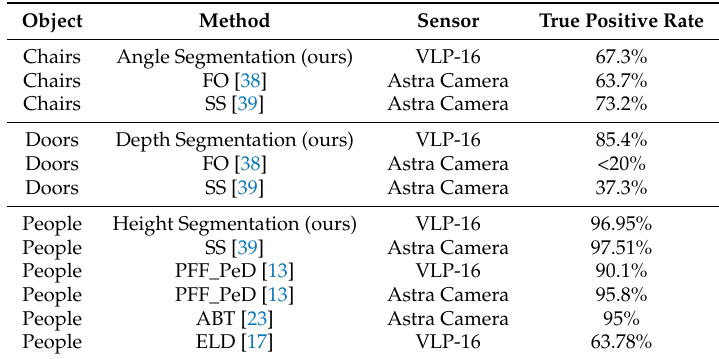
Table 4. Accuracy in object detection. Depending on the type of object we compare different